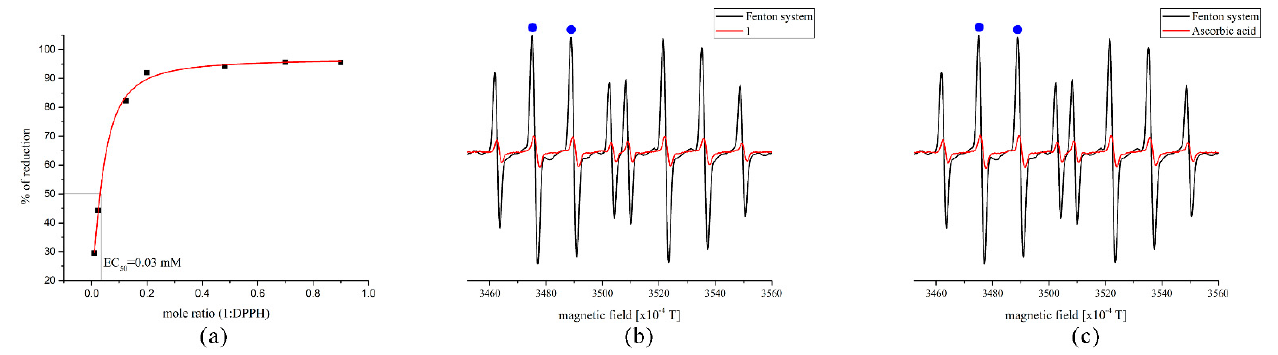
Figure 9. ( a ) Dependence of the reduction percentage of DPPH • on the mole ratio between 1 and DPPH • ; ( b ) EPR spectra of DEPMPO-HO • adduct with and without 1; and ( c ) EPR spectra of DEPMPO-HO • adduct with and without ascorbic acid. (Blue circles denote peaks used for evaluation of antiradical